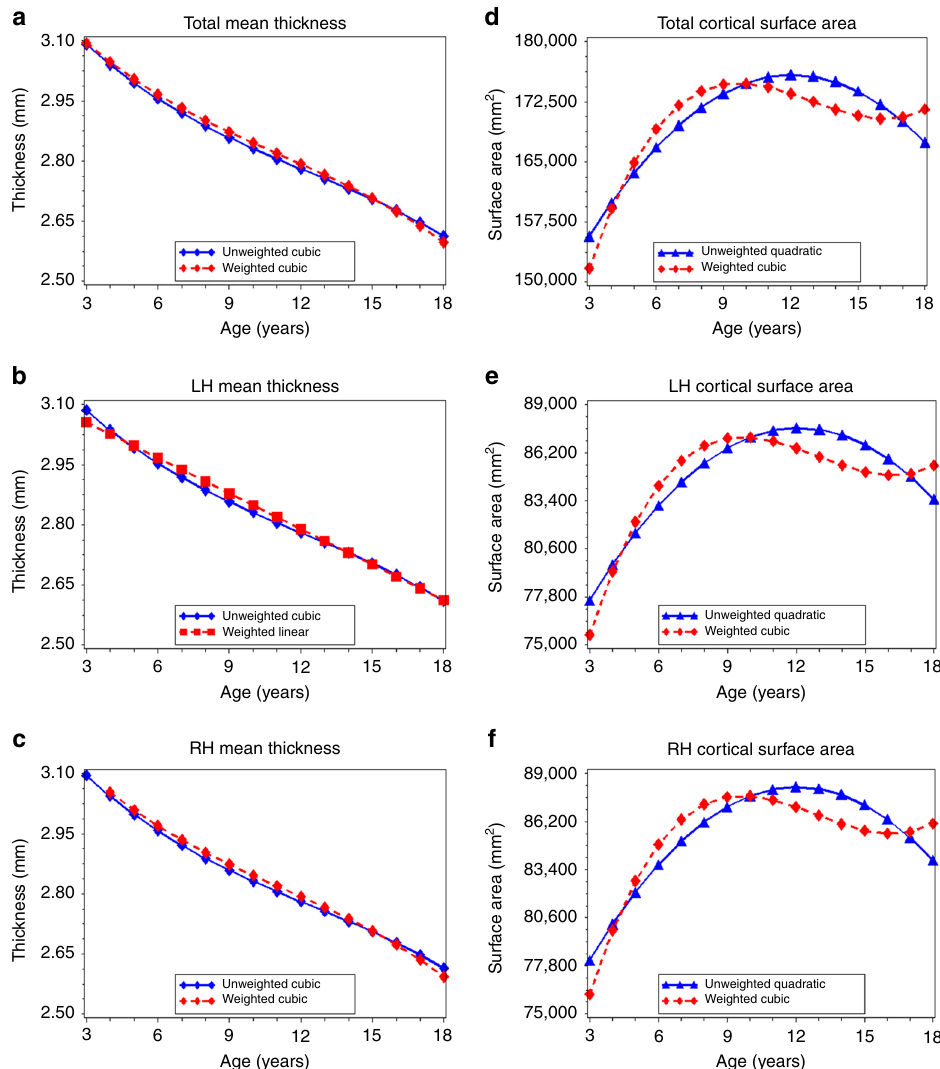
Fig. 2 Age-related variation in cortical thickness and cortical surface area. Using the best- fi tting regression models described in Table 2, we calculated the predicted values by age for total mean cortical thickness ( a ), left hemispheric cortical thickness ( b ), right hemispheric cortical thickness ( c ), total cortical surface area ( d ), left hemispheric cortical surface area ( e ), and right hemispheric cortical surface area ( f ) in the unweighted ( blue lines ) and weighed ( red lines ) samples. LH left hemisphere, RH right